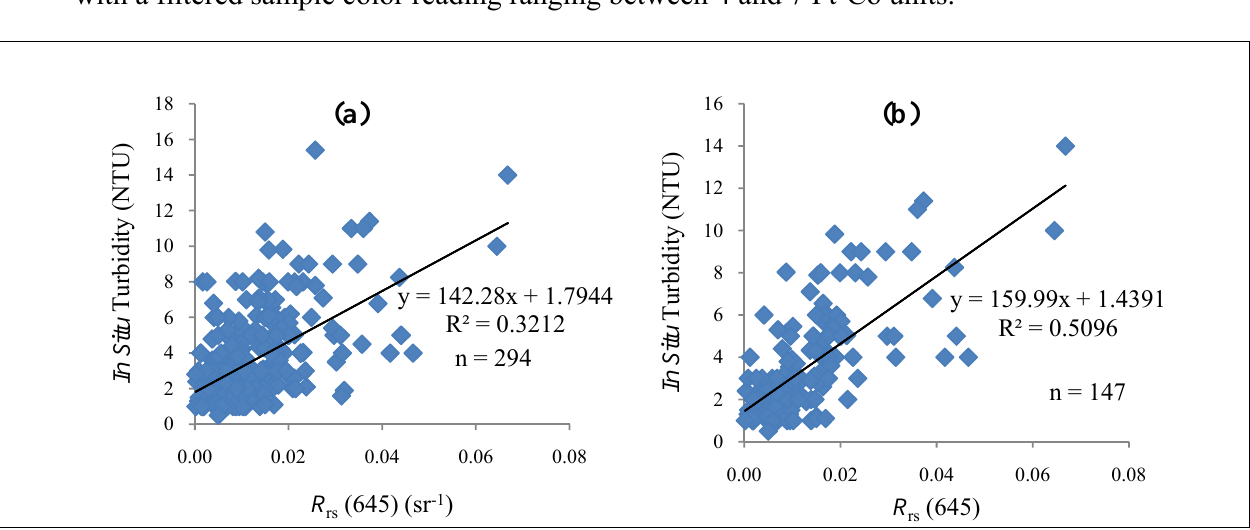
Figure 2. Relationships between in situ turbidity (NTU) and R rs from MOD09GQ when considering (a) all the matched up pairs available and (b) when selecting only those pairs with a filtered sample color reading ranging between 4 and 7 Pt-Co